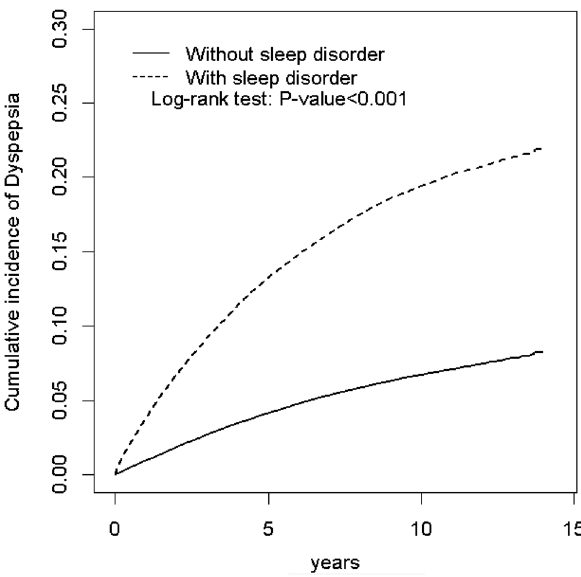
Figure 1. Kaplan-Meir method determined cumulative incidence of Dyspepsia compared between sleep disorder cohorts and comparisons without sleep